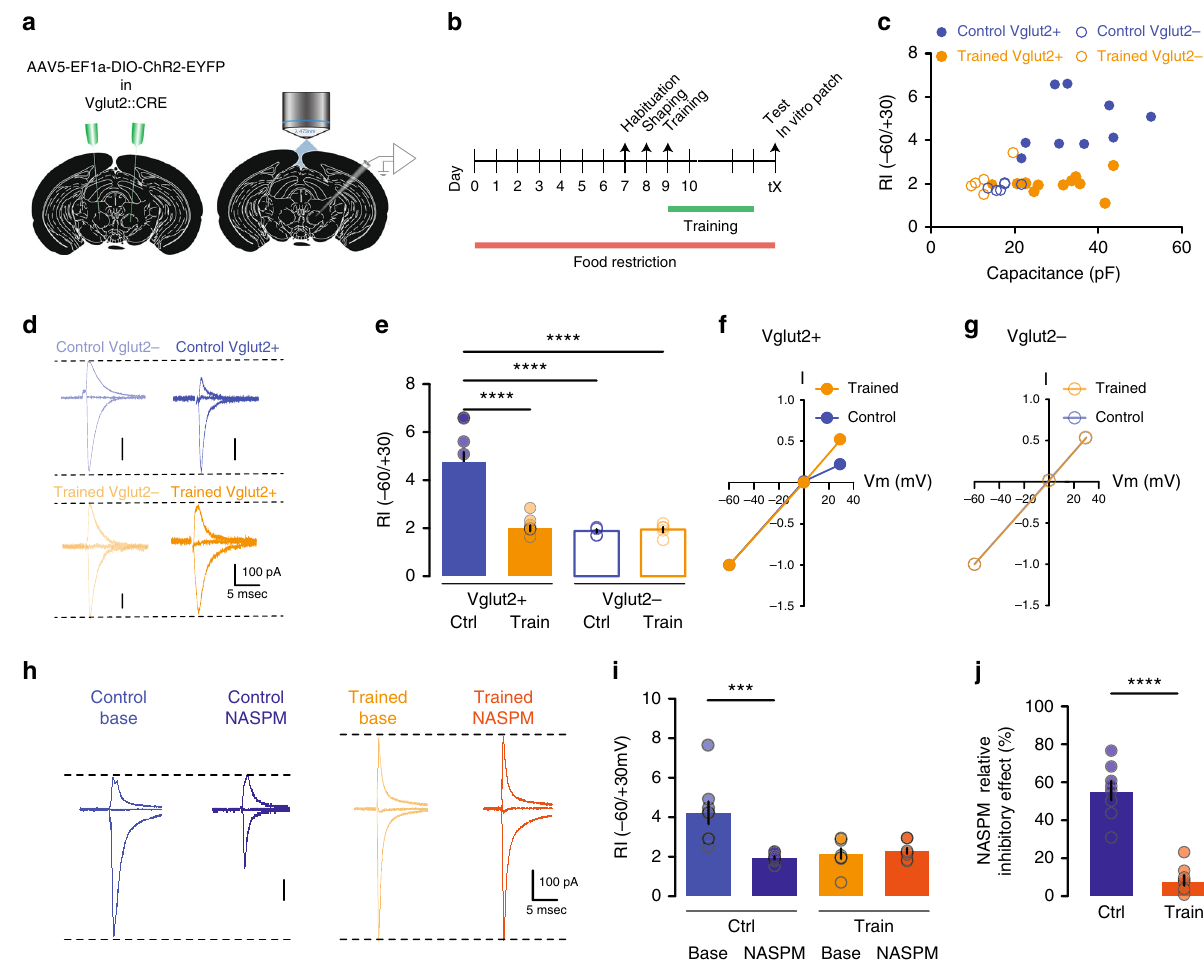
Fig. 6 Vglut2-positive neurons undergo training-dependent plasticity. a Schematic of ChR2-eYFP injection in the RN of Vglut2-CRE mice and patch-clamp recording. b Timeline. c , d Recti fi cation index vs cell capacitance ( c ) with example traces ( n = 6 – 11 cells/group) in d . e – g Recti fi cation index ( e ), 2W- ANOVA F (1,26) = 22.72, P < 0.0001 and corresponding I/V curves in f and g ( n = 5 – 11 cells/group). h Example EPSC traces before and after bath- application of NASPM ( n = 8 cells/group). i Effect of NASPM on Recti fi cation index. j NASPM inhibitory effect. All data are reported as mean and SEM. Results obtained from control mice are displayed in blue (ctrl) whereas data obtained from trained mice (train) are shown in orange. Filled symbols represent data recorded from Vgut2-positive neurons and open symbols are data recorded from Vglut2-negative